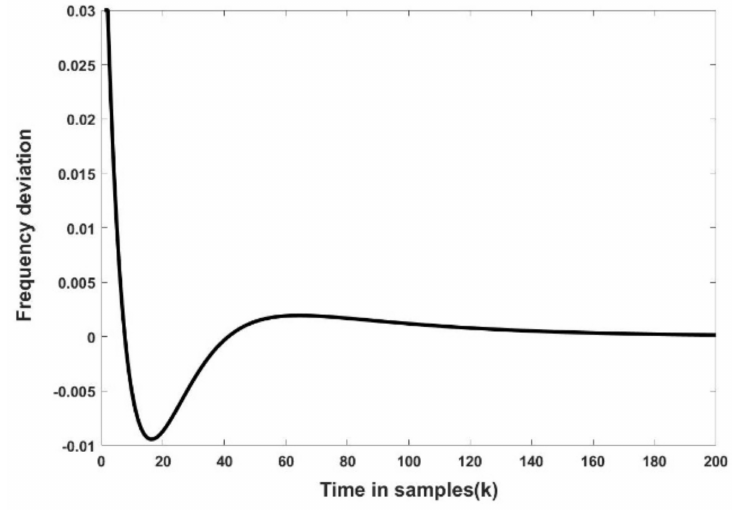
Figure 6. Dynamic response of frequency using IPSO-BP-PI strategy with DFIG-based wind turbine.